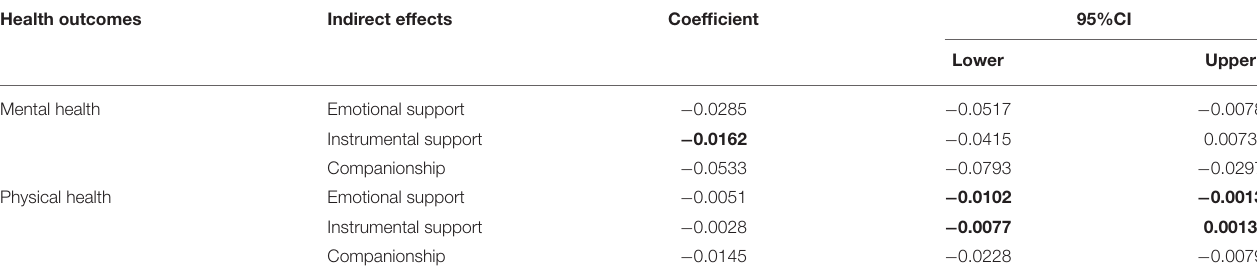
TABLE 7 | Causal mediation effects of the subtypes of social support in the association between widowhood and health status in the whole sample ( N =